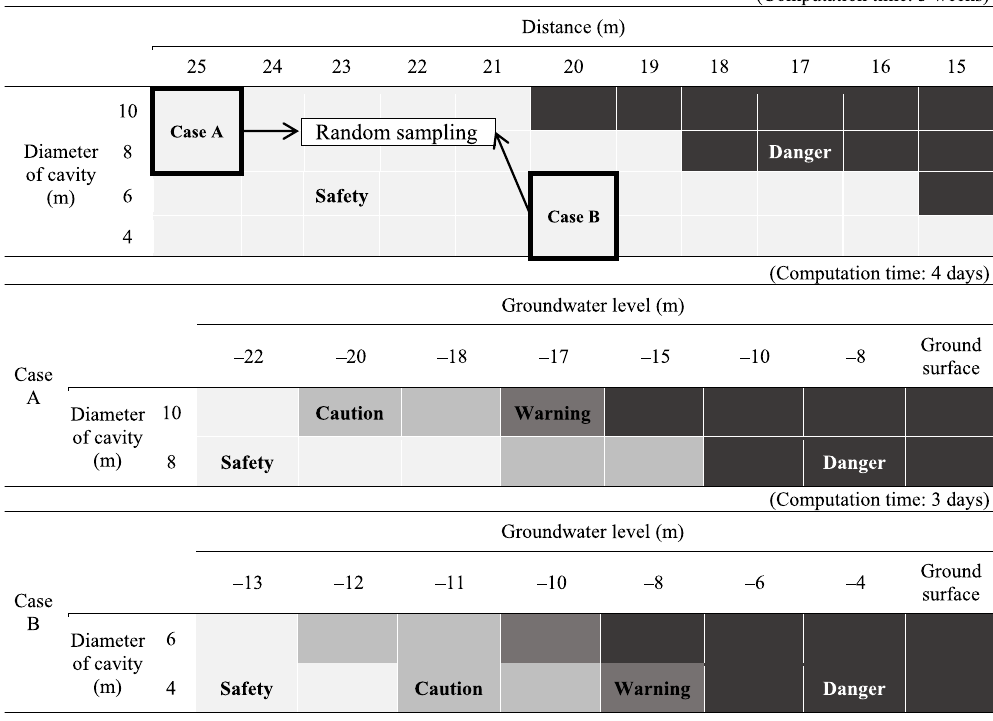
Table 2. Risk level of the roadbed with respect to the diameter of the cavity and the distance between the roadbed and the cavity for the groundwater condition. Safety (settlement ≤ 2 . 5mm), caution (2.5mm < settlement ≤ 4 . 0mm), warning (4.0mm < settlement ≤ 9 . 0mm) and danger (9.0mm <